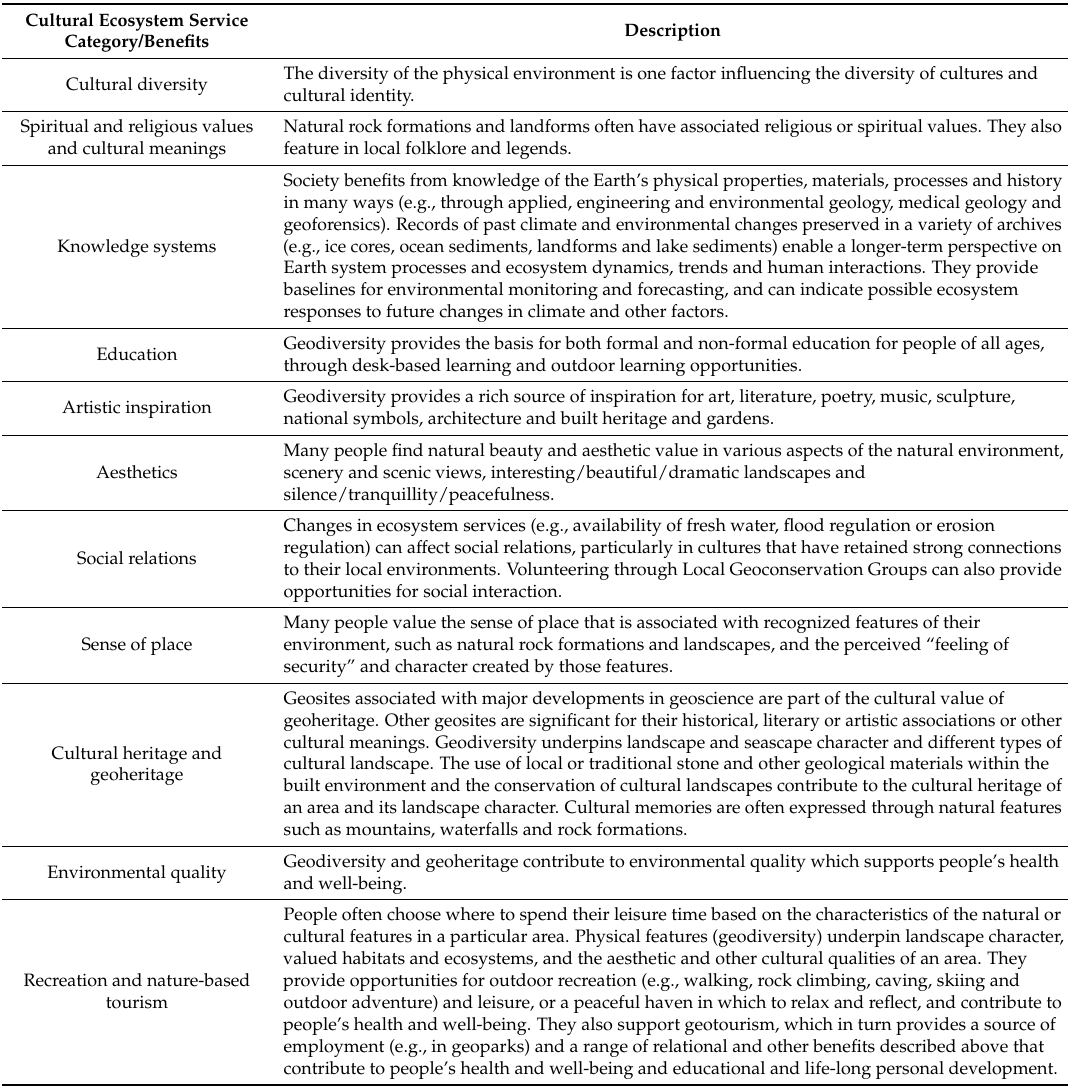
Table 1. Cultural ecosystem services and benefits arising from geodiversity and geoheritage (adapted from